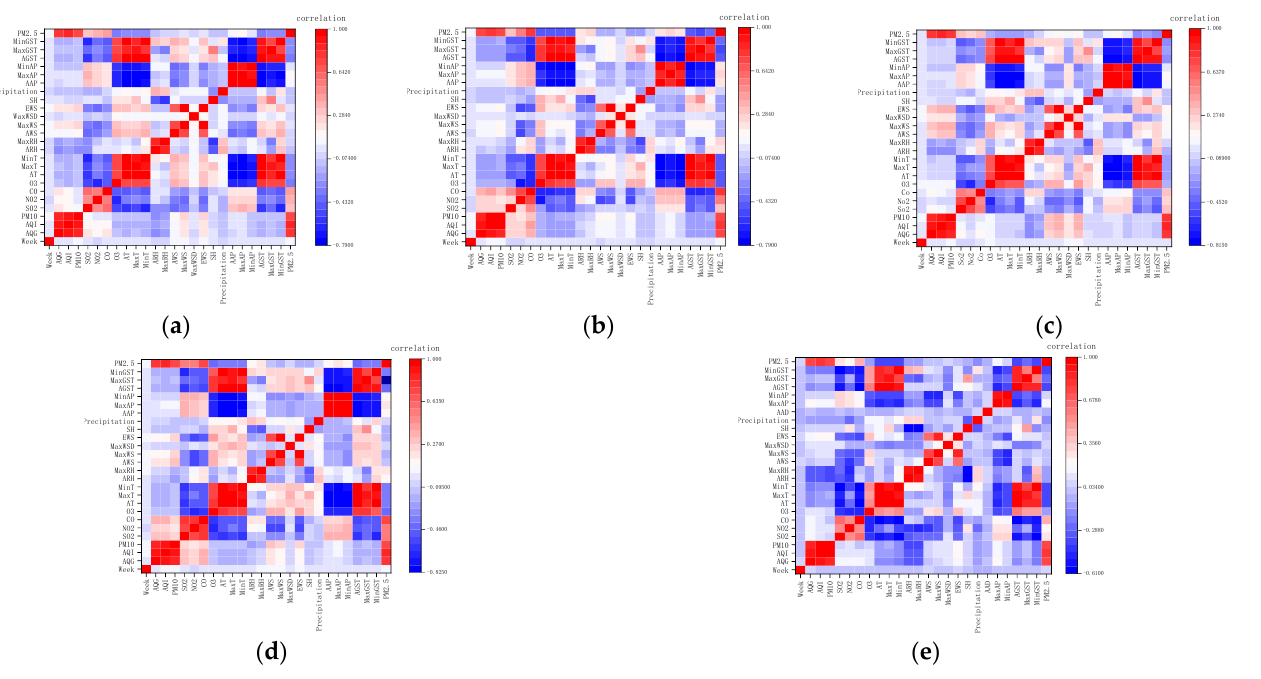
Figure 4. Correlation coefficient heat plot. ( a ) Wuzhong; ( b ) Yinchuan; ( c ) Zhongwei; ( d ) Shizuishan; ( e ) Guyuan.